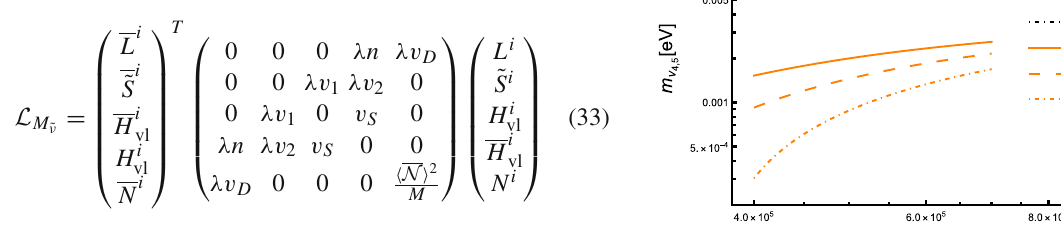
the diagonalization procedure as a function of the λv 2 param- eter for different values of λ n . These values are compatible with the current experimental findings from global fits of neutrino oscillation data [50] and mass measurements from the KATRIN collaboration [51].